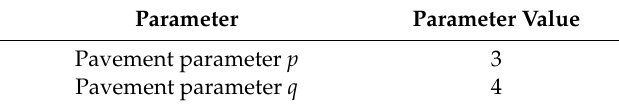
Table 4. Pavement parameters in highway scene with heavy rain.